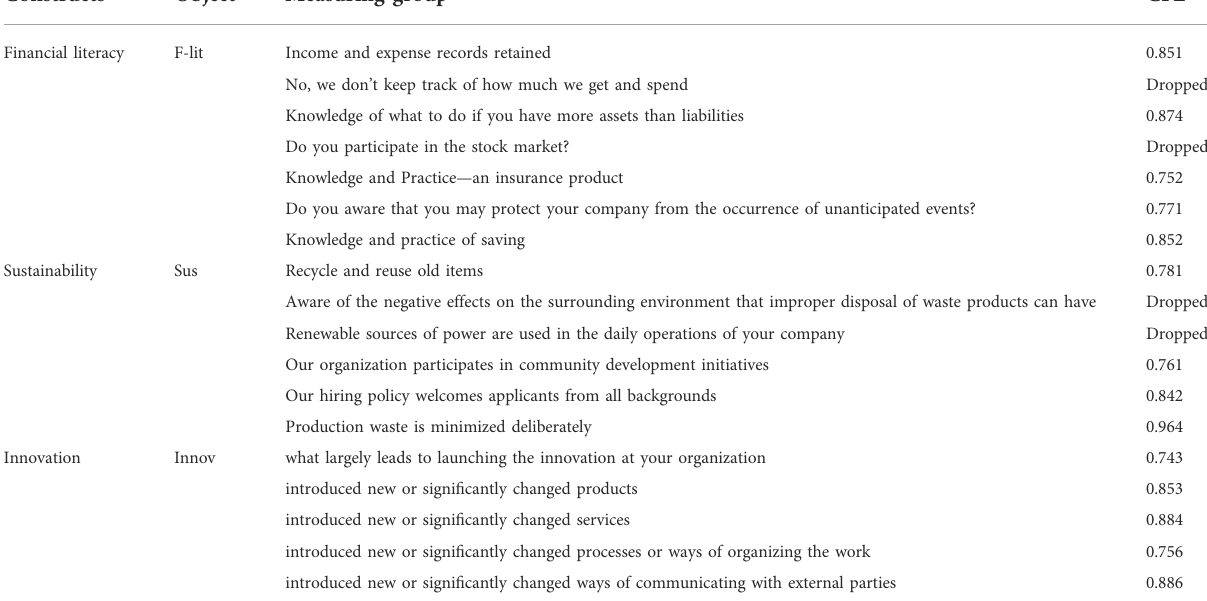
TABLE 4 Con fi rmatory factor loading (CFL).